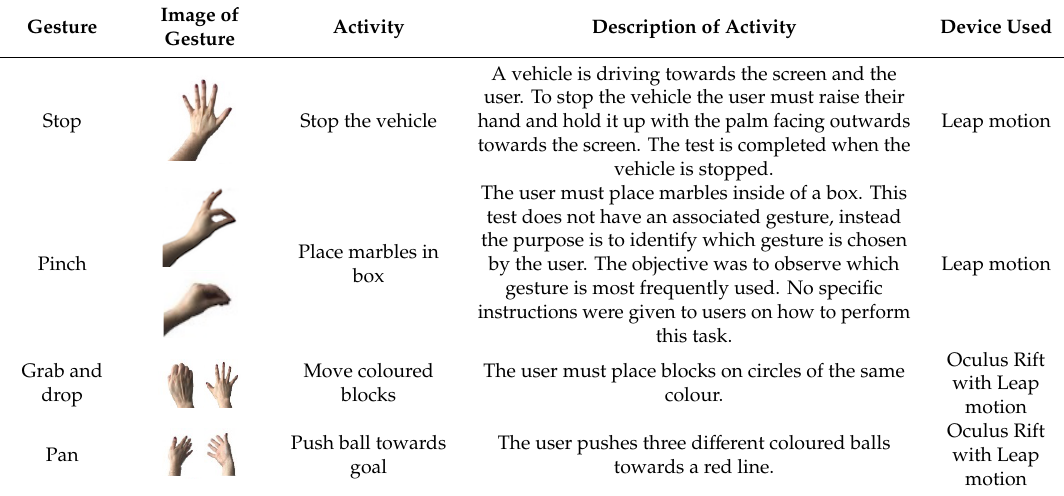
Table 2. Vocabulary of 3D gestures for Leap Motion, Atheer and Oculus Rift.